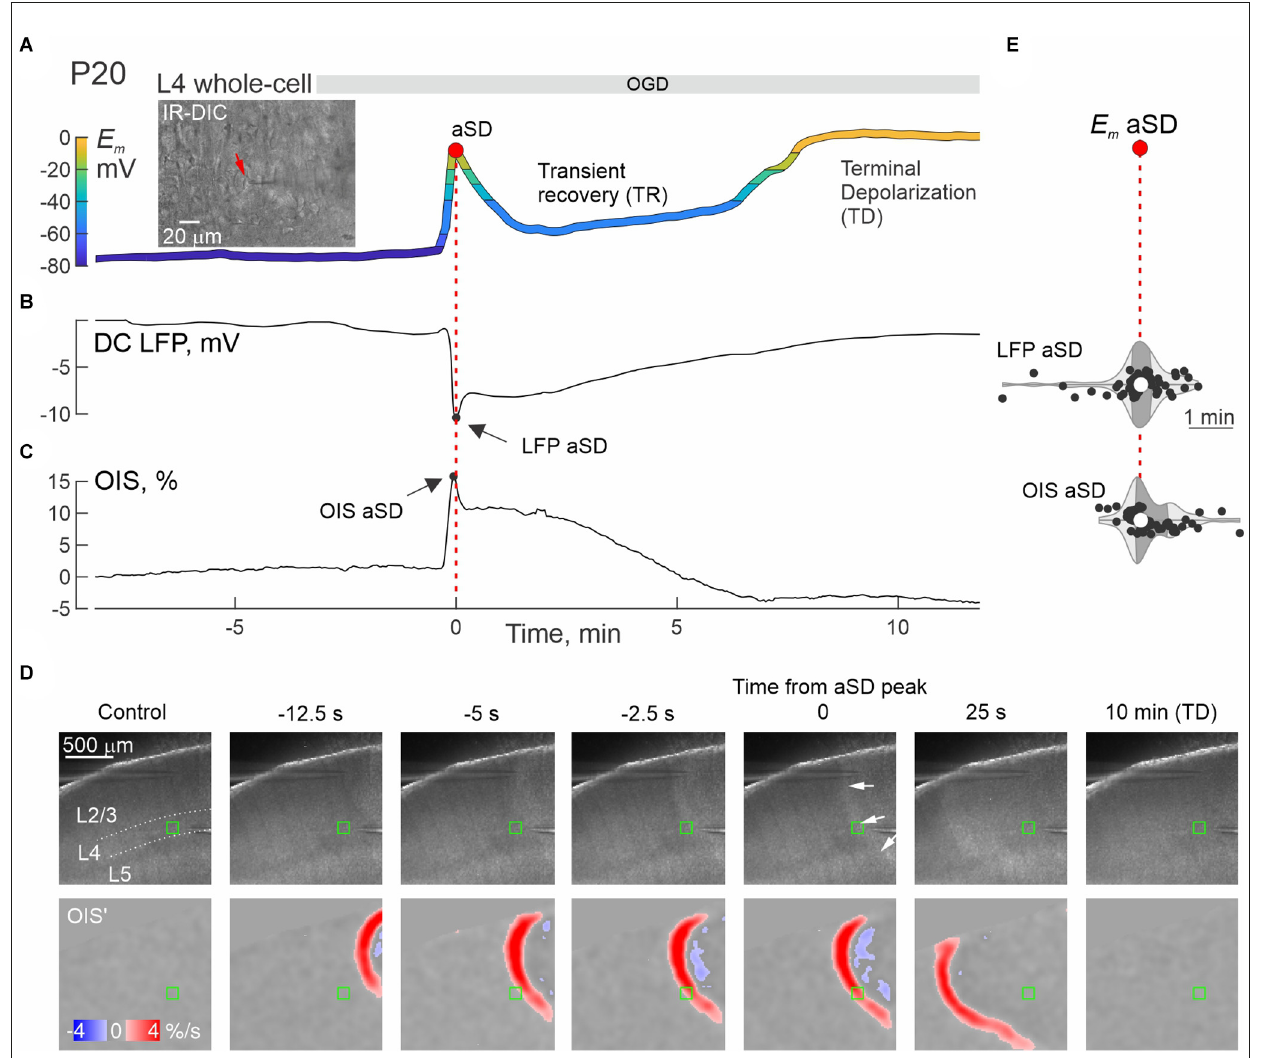
FIGURE3 aSD correlates with negative LFP shifts and an increase in optical tissue transparency in the developing cortex. (A–C) Simultaneous whole-cell E m recordings from an L4 neuron (A) , extracellular DC-LFP recordings (B) , and OIS recordings (C) near the recorded neuron during OGD in a P20 rat somatosensory cortex slice. T = 0 indicates aSD peak during whole-cell recordings ( E m —aSD). The inset on panel (A) shows an IR-DIC image of layer 4 (40x magnification), the neuron being recorded is marked with a red arrow. (D) Microphotograph of a slice (4x magnification, raw data, top panels) and the OIS first derivative (bottom panels) at different delays from aSD recorded from the L4 neuron shown on panel (A) . The region of interest (ROI) for OIS quantified in panel (C) is indicated by a green rectangle. (E) Distribution of aSD delays recorded by extracellular electrodes (LFP—aSD) and OIS (OIS—aSD) from aSD during whole-cell recordings ( E m —aSD, vertical dotted line). Hereafter, each dot corresponds to an individual cell/slice, the violin plots show the probability density of the data at different values smoothed by the kernel density estimator, the white circles are the median, and the dark shaded area is the interquartile range. Pooled data from n = 58 cells/slices from P3 to P31 rats. There was no significant time lag between LFP—aSD ( p = 0.54), OIS—aSD ( p = 0.93, Wilcoxon rank sum test), and E m